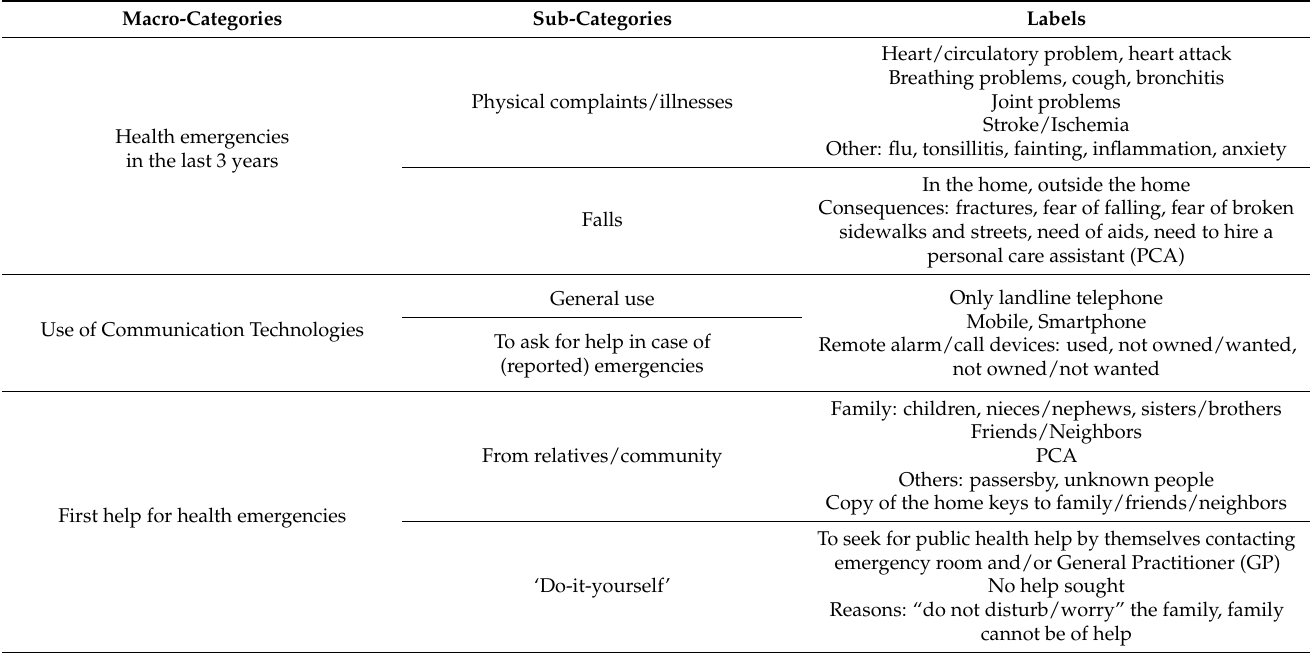
Table 1. Overview of macro-categories, sub-categories, and